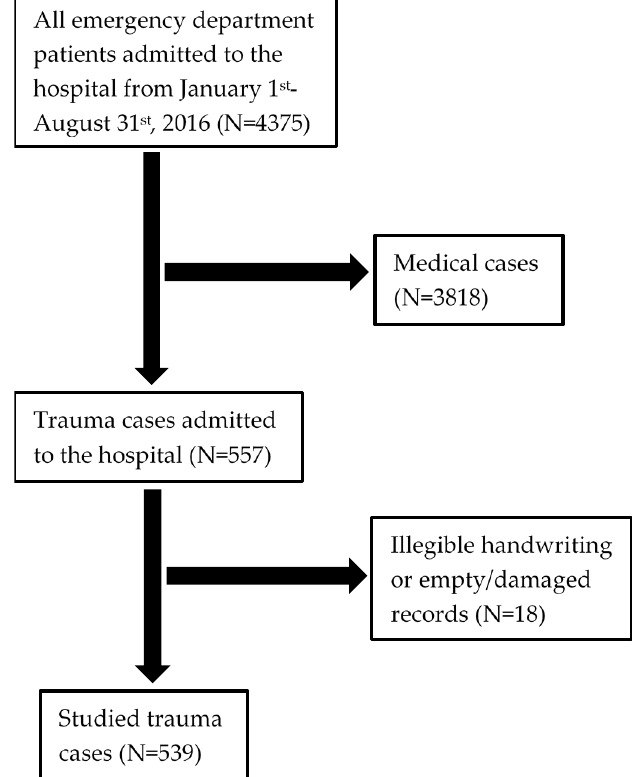
Figure 1. Flow diagram of included and excluded records for analysis.